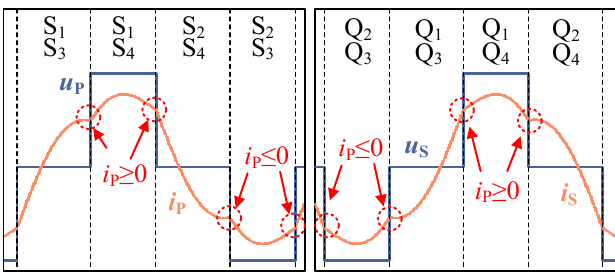
Figure 7. Main voltage and current waveforms of no backflow power.